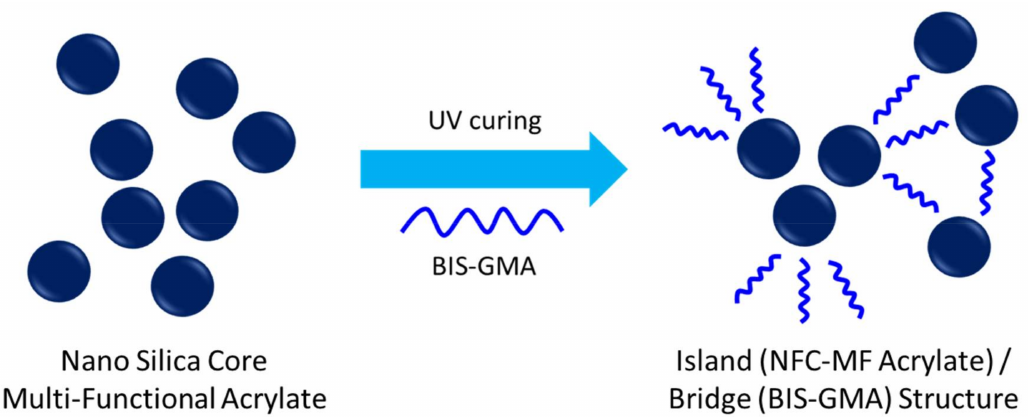
Figure 15. Island/bridge structure of the mixture system of NFC MF acrylate and BIS-GMA.